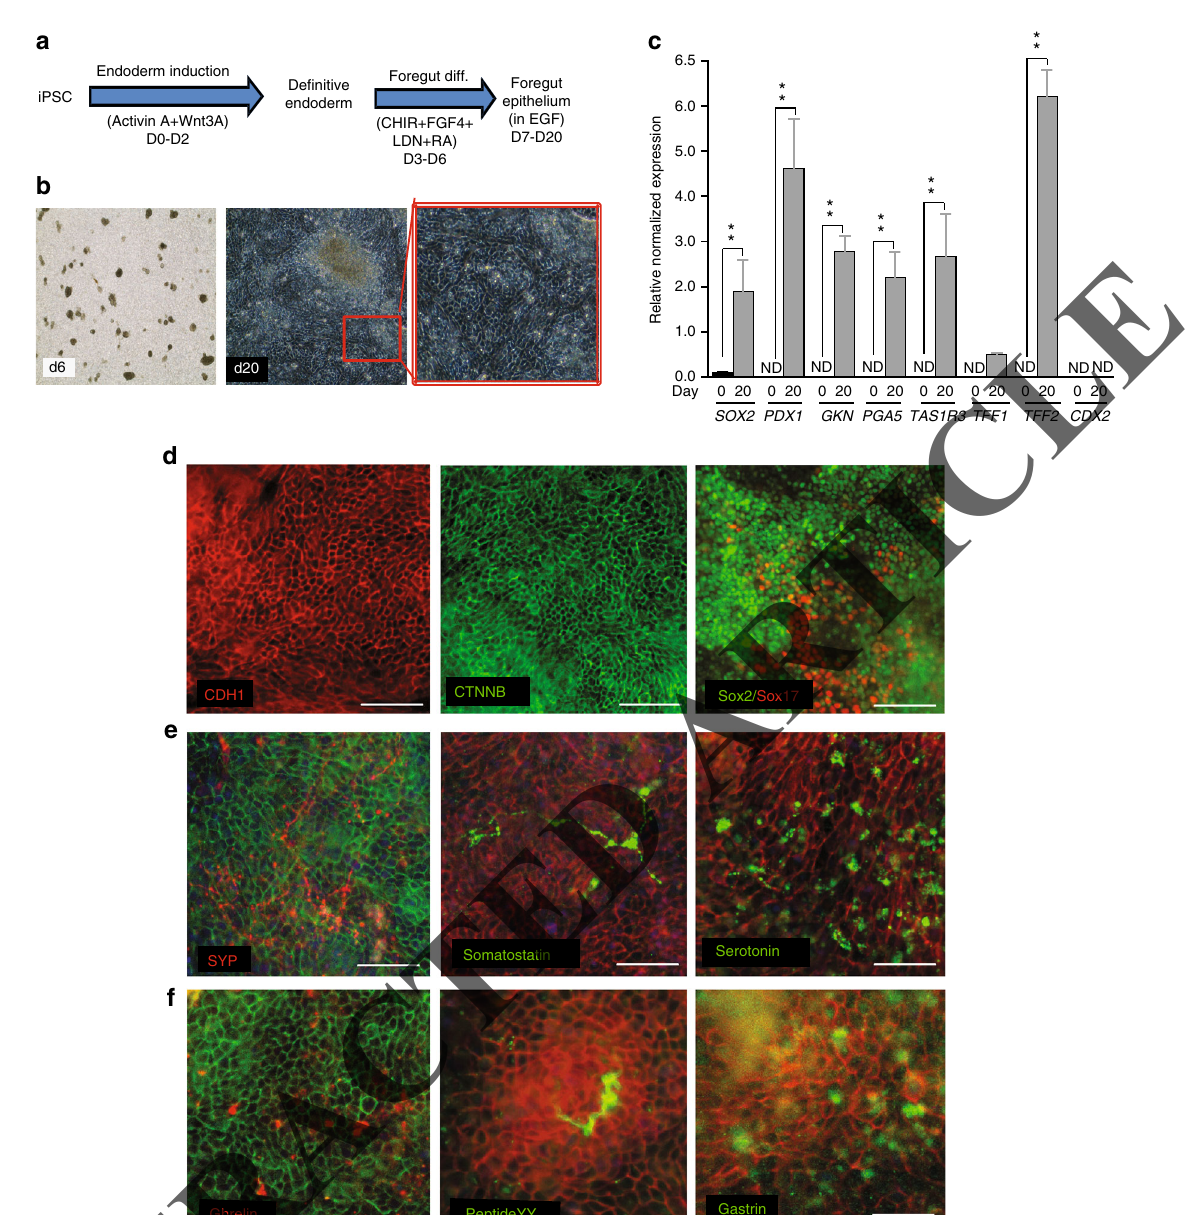
Fig. 1 Human iPSCs differentiate into foregut epithelium (iFGE) by modulation of WNT, FGF, BMP, and RA. a iFGE differentiation protocol. b Bright fi eld images of day 6 and day 20 old iFGE. c RT-qPCR of foregut genes shown to be signi fi cantly increased (** p < 0.01) in day 20 iFGE compared with day 0. ND not detectable. Two-way ANOVA was employed to determine differences within day 0 and day 20 iFGEs. d Foregut epithelial markers, E-cadherin (CDH1), β -catenin (CTNNB), and endoderm and foregut progenitor markers, Sox2 and Sox17. e Expression of neuroendocrine markers such as synaptophysin (SYP), somatostatin and serotonin. f ( Top to bottom ) Gastric endocrine-positive cells such as ghrelin, peptide YY, and gastrin. All markers from d , e , and f are co-labeled with an epithelial marker such as E-cadherin ( red ) or β -catenin ( green ). Images and data shown are representative of average results from the two iPSC lines differentiated n = 5 times in independent experiments. Scale bars represent 50 µ m. Error bars denote